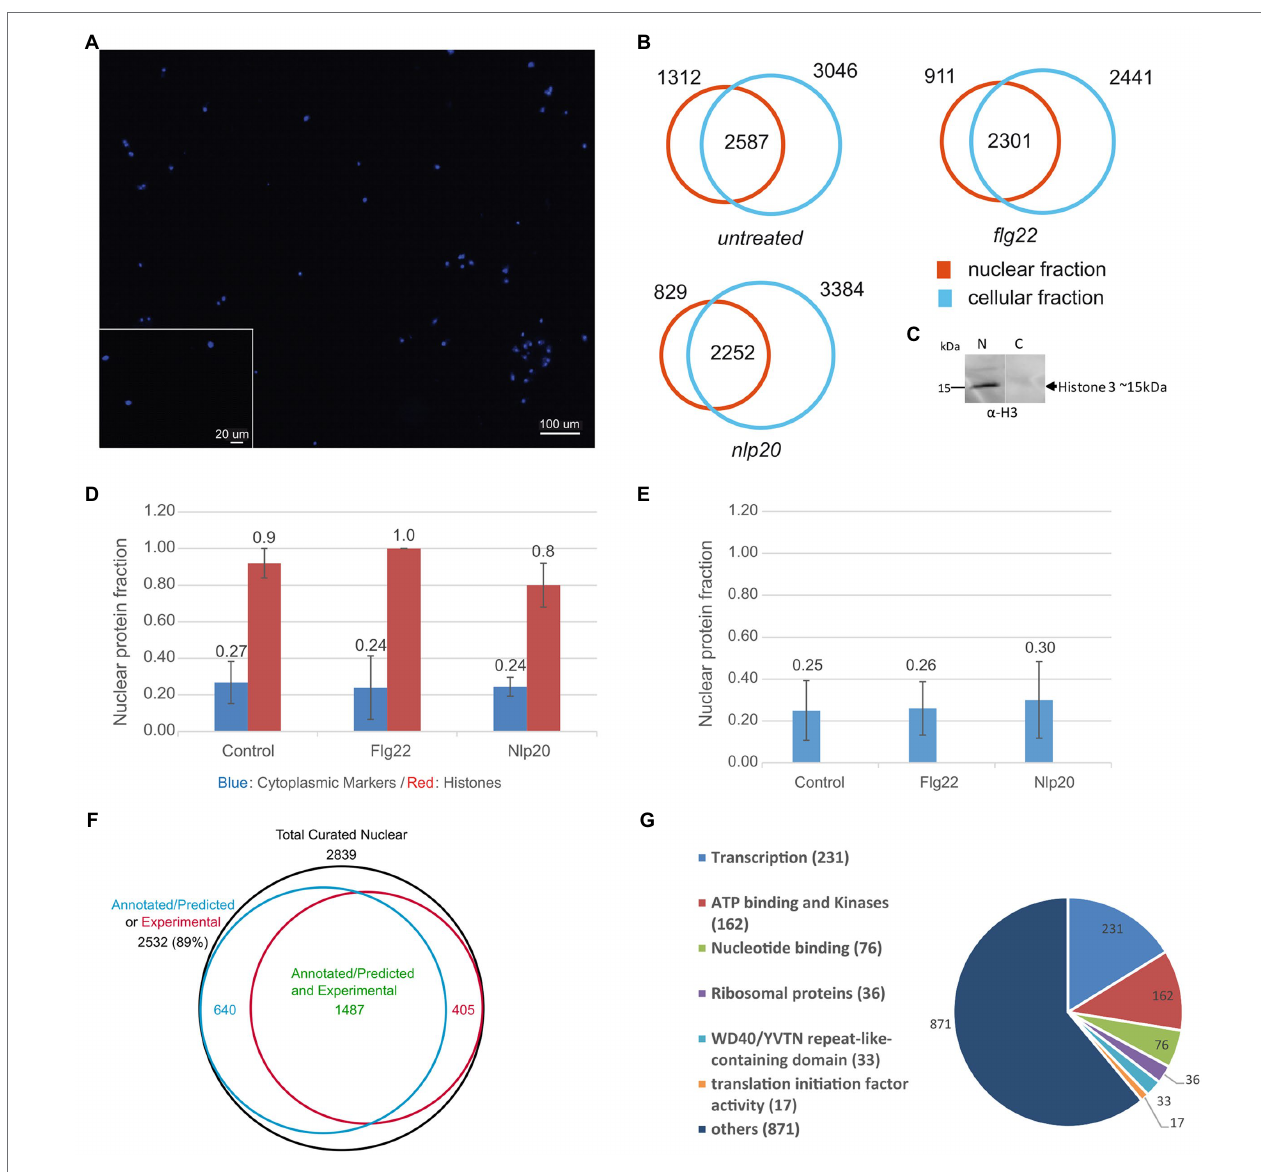
FIGURE 1 | Extraction of the nuclear proteome. (A) DAPI staining fluorescence microscopy of nuclei isolated from dark grown Arabidopsis thaliana cell culture. (B) Total proteins identified in nuclear and cellular fractions in three independent experiments in untreated, flg22 and nlp20 treated cell cultures. (C) Western blot of nuclear (N) and cellular (C) proteins with anti-Histone H3 antibody, respective Mw range is shown. (D) Median nuclear enrichment scores (Npfn values) in three independent experiments of all identified histone proteins and of cytoplasmic markers (two cytoplasmic markers were absent in shared proteins in flg22 and nlp20 conditions and were not used in both conditions). Error bars denote median absolute deviation. (E) Median Npfn values of mitochondrial and Golgi markers. Error bars denote median absolute deviation. (F) VENN diagram showing sets of experimentally validated or annotated/ predicted nuclear proteins, comprising our data set. (G) DAVID gene ontology classification of 1,426 proteins of the untreated nuclear protein fraction annotated as nuclear proteins by DAVID bioinformatics